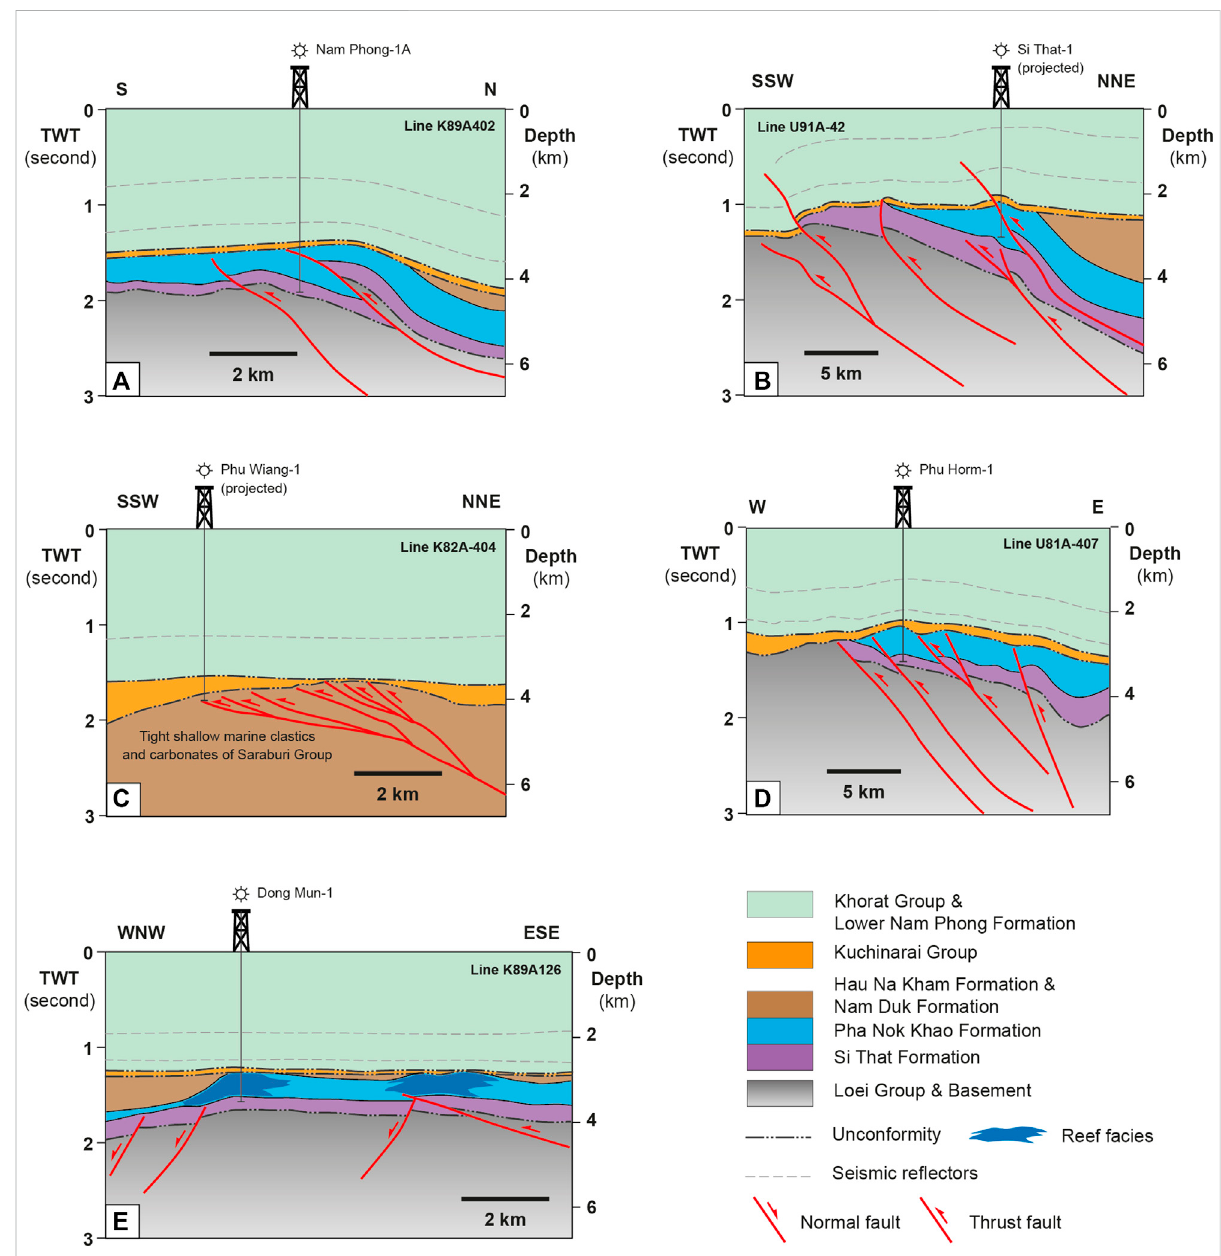
FIGURE 11 Simpli fi ed geological cross-section of the structural traps related to producing and abandoned petroleum fi elds in the Khorat Plateau. (A) Nam Phong structure, (B) Si That structure, (C) Phu Wiang structure, (D) Phu Horm structure, and (E) Dong Mun Structure (modi fi ed from Booth, 1998; Booth and Sattayarak,